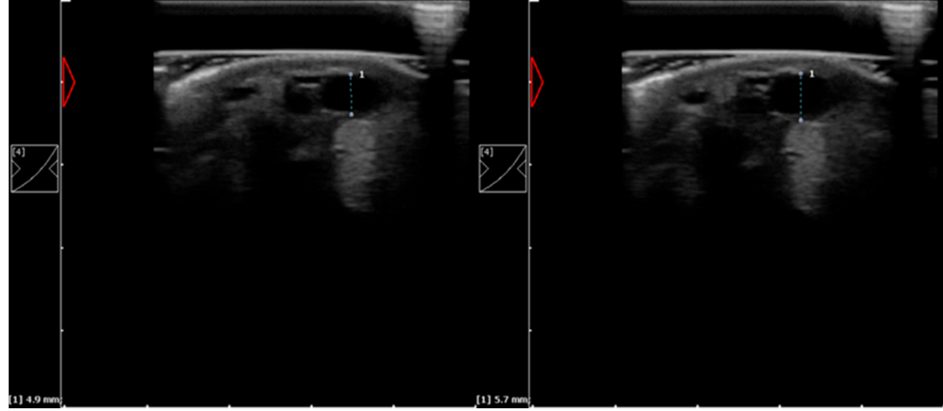
Figure 2. Example of ultrasound images of the lateral palmar digital vein with diameter measurement of the left pigmented hindlimb fetlock joint taken before (on the left ) and after HILT (on the right